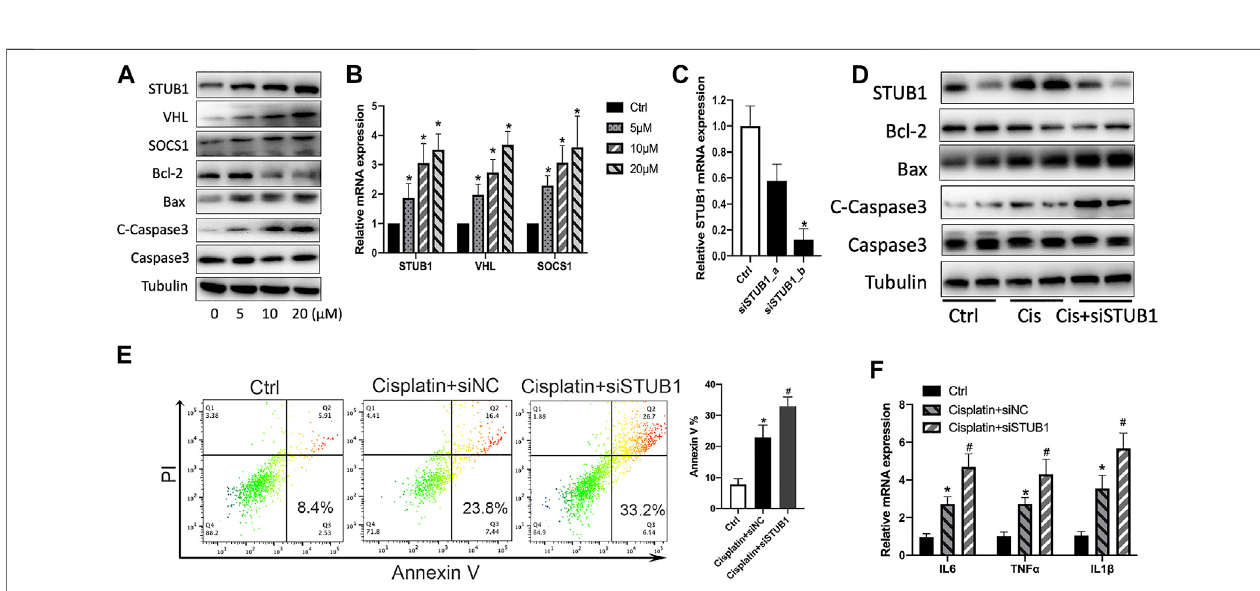
FIGURE 8 | STUB1 inhibition promoted apoptosis of HK-2 cells induced by cisplatin. (A) Western blot of STUB1, VHL, and SOCS1 in HK-2 cells treated with 0- 5 – 10 – 20 μ Mcisplatin. (B) qPCRofSTUB1,VHL,andSOCS1mRNAlevelsinHK-2cellstreatedwith0-5 – 10 – 20 μ Mcisplatin(n (cid:2) 3).* p < 0.05,comparedtocontrol. (C) Knockdown ef fi ciency of STUB1 in HK-2 cells by qRT-PCR ( n (cid:2) 3). * p < 0.05, compared to control. (D) Apoptosis of HK-2 cells treated with 20 μ M cisplatin and STUB1 knockdown by western blot analysis. (E) Annexin V apoptosis analysis of HK-2 cells treated with 20 μ M cisplatin and STUB1 knockdown. * p < 0.05, compared to control; # p < 0.05, compared to the cisplatin + siNC group ( n (cid:2) 3). (F) Proin fl ammatory cytokine production of HK-2 cells treated with 20 μ M cisplatin and STUB1 knockdown by qRT-PCR analysis ( n (cid:2) 3). * p < 0.05, compared to control; # p < 0.05, compared to the cisplatin + siNC group.